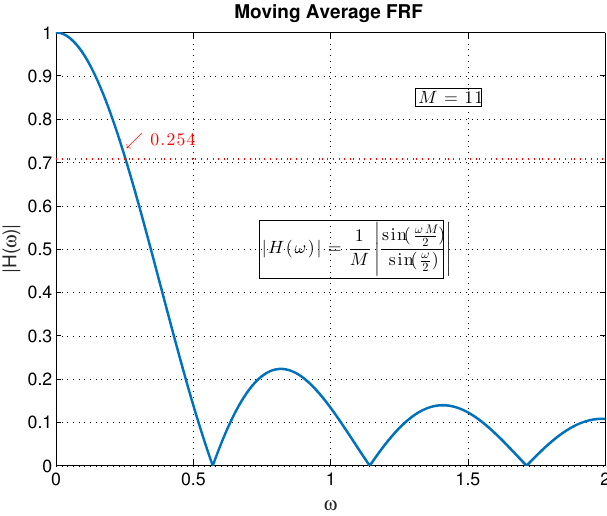
Figure 6. Example of frequency response of a moving average